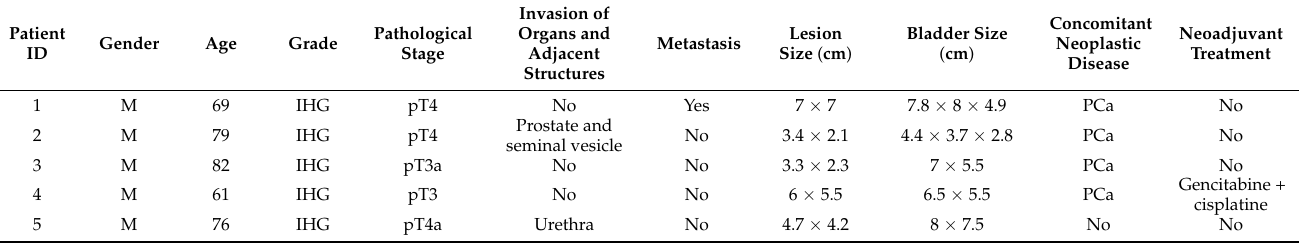
Table 1. Clinical and histopathological parameters of bladder cancer patients included in the study.